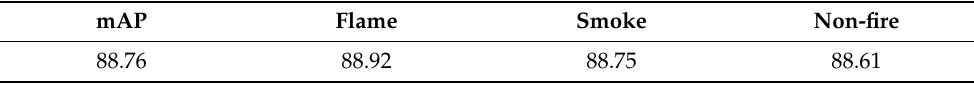
Table 5. mAP of Faster R-CNN